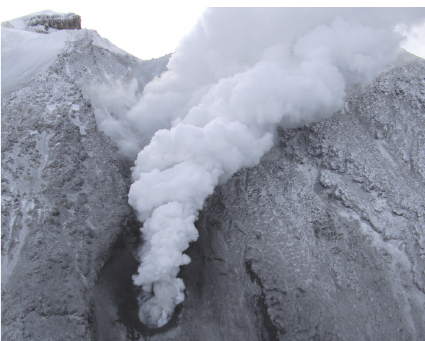
Figure 20: Koryaksky fumarole (FK), 01 Oct. 2010. Photo by A. V. Kiryukhin.